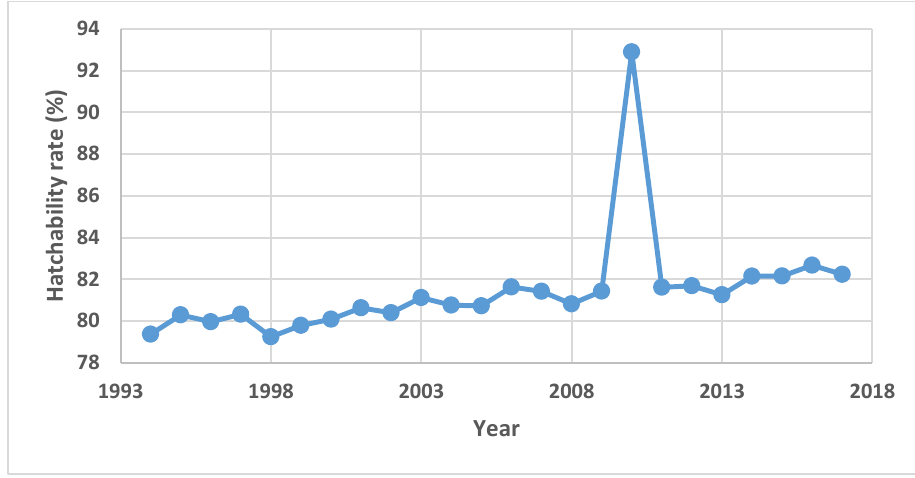
Figure 6. Hatchability rates for Canadian egg production.